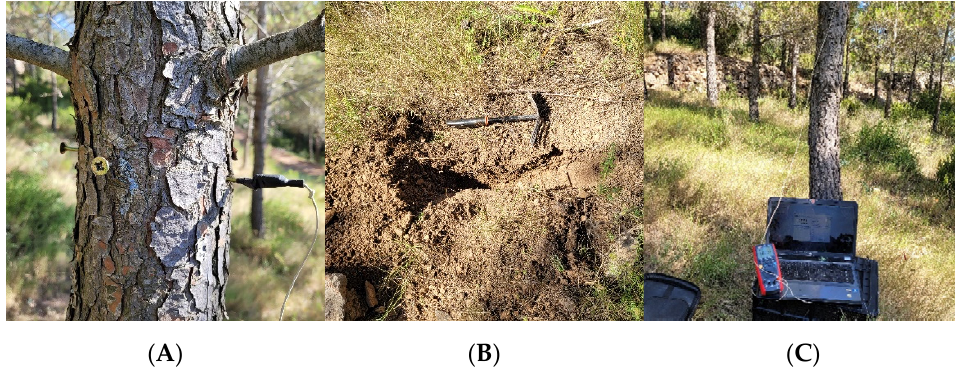
Figure 2. Tree electrode ( A ), ground electrode placement ( B ), arrangement of measuring equipment ( C